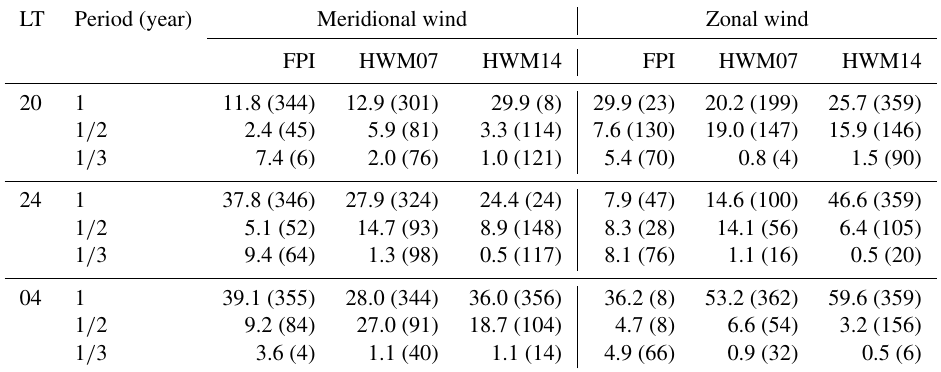
Table 1. The annual, semiannual, and terannual harmonic fits to the meridional and zonal winds for the Moroccan FPI data, HWM07, and HWM14 at 20:00, 24:00, and 04:00LT. The amplitude is in ms − 1 and the phase (in parentheses) is in DOY. LT Period (year) Meridional wind Zonal wind